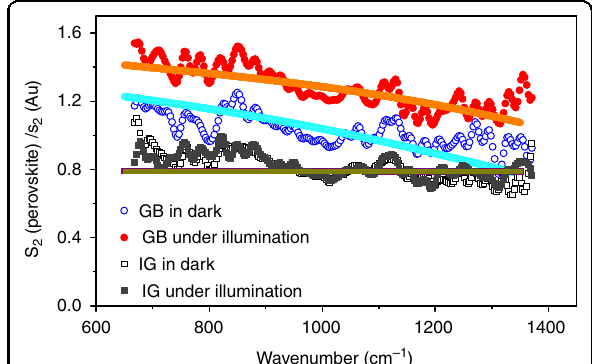
Fig. 3 Near- fi eld spectra s 2 (perovskite)/ s 2 (Au) of CH 3 NH 3 PbI 3 polycrystalline fi lm ( s 2,IG / s 2,Au at position A and s 2,GB / s 2,Au at position B marked in Fig. 1b). The solid lines show calculations performed with the fi nite dipole model of s-SNOM, using a probe with tip-radius of 25 nm and tip-tapping amplitude of 60 nm. The charge mobility and dielectric data for CH 3 NH 3 PbI 3 are taken from the literatures; 2,51 and the free-carrier density n is the fi tting parameter. The best agreement between the calculations and the experiments on CH 3 NH 3 PbI 3 was found for a free-carrier density n = 6 × 10 19 cm − 3 at GB in the dark and n = 8 × 10 19 cm − 3 at GB under 532 nm